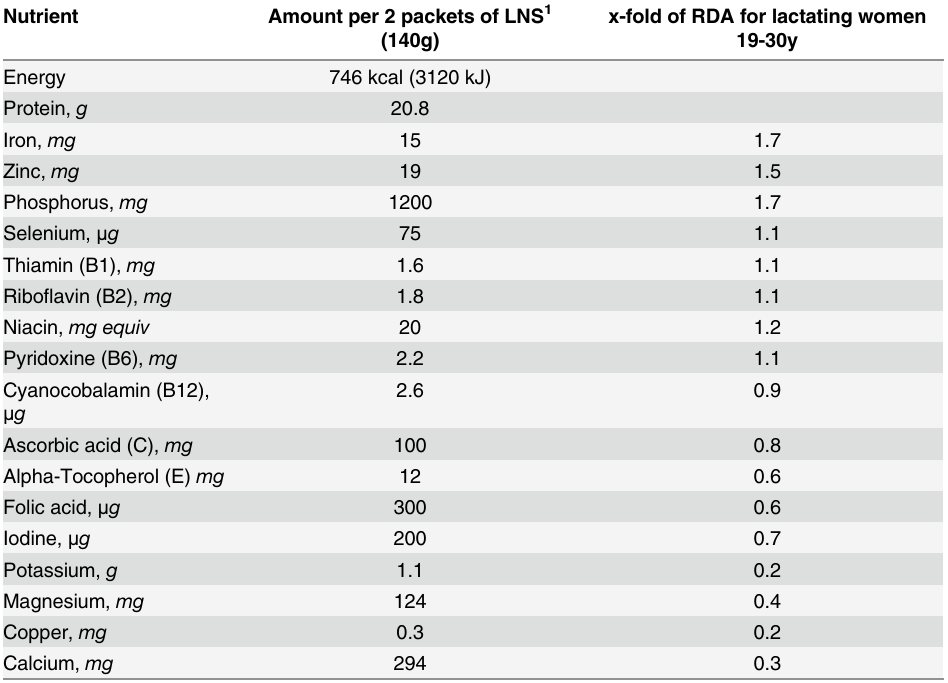
Table 1. LNS composition formulated for lactating women and relative amount of micronutrients in LNS (x-fold) compared to the RDA. Nutrient